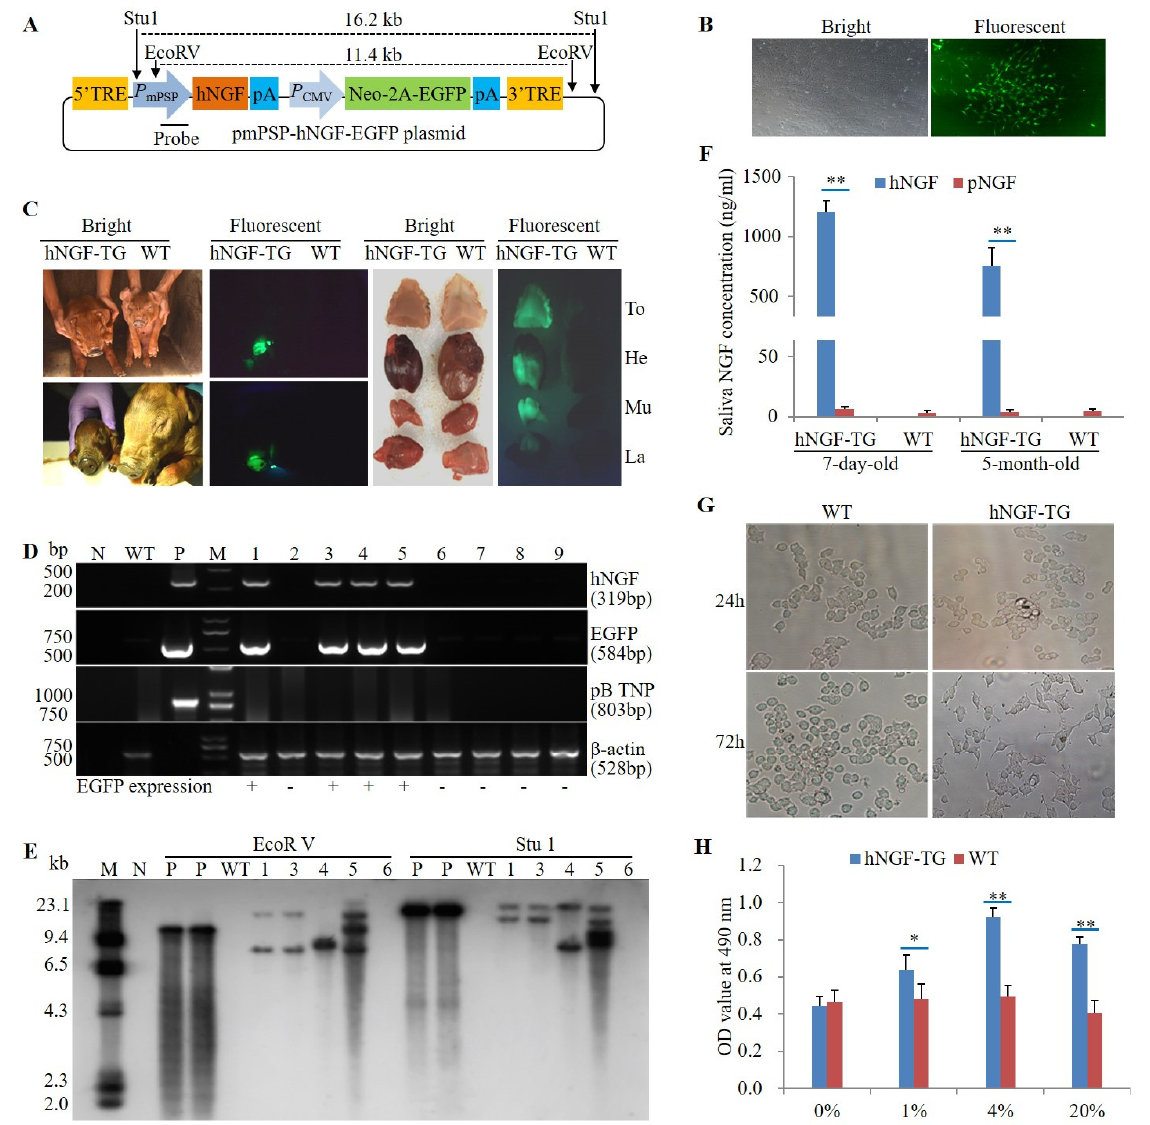
Figure 1. Production and identification of F 0 generation hNGF ‐ TG pigs. ( A ) The map of the pmPSP ‐ hNGF ‐ EGFP piggyBac transposon plasmid. 5 ′ TRE and 3 ′ TRE: the piggyBac transposon 5 ′ and 3 ′ terminal repeat elements. P mPSP : the mouse parotid secretory protein (PSP) gene promoter, which is a salivary glands ‐ specific promoter. hNGF: the hNGF gene coding sequences. pA: poly A signal. P CMV : the cytomegalovirus promoter. Neo-2A-EGFP: the neomycin-resistance gene linked with the EGFP gene by a 2A peptide. The location of the probe and enzyme cutting sites for Southern blot